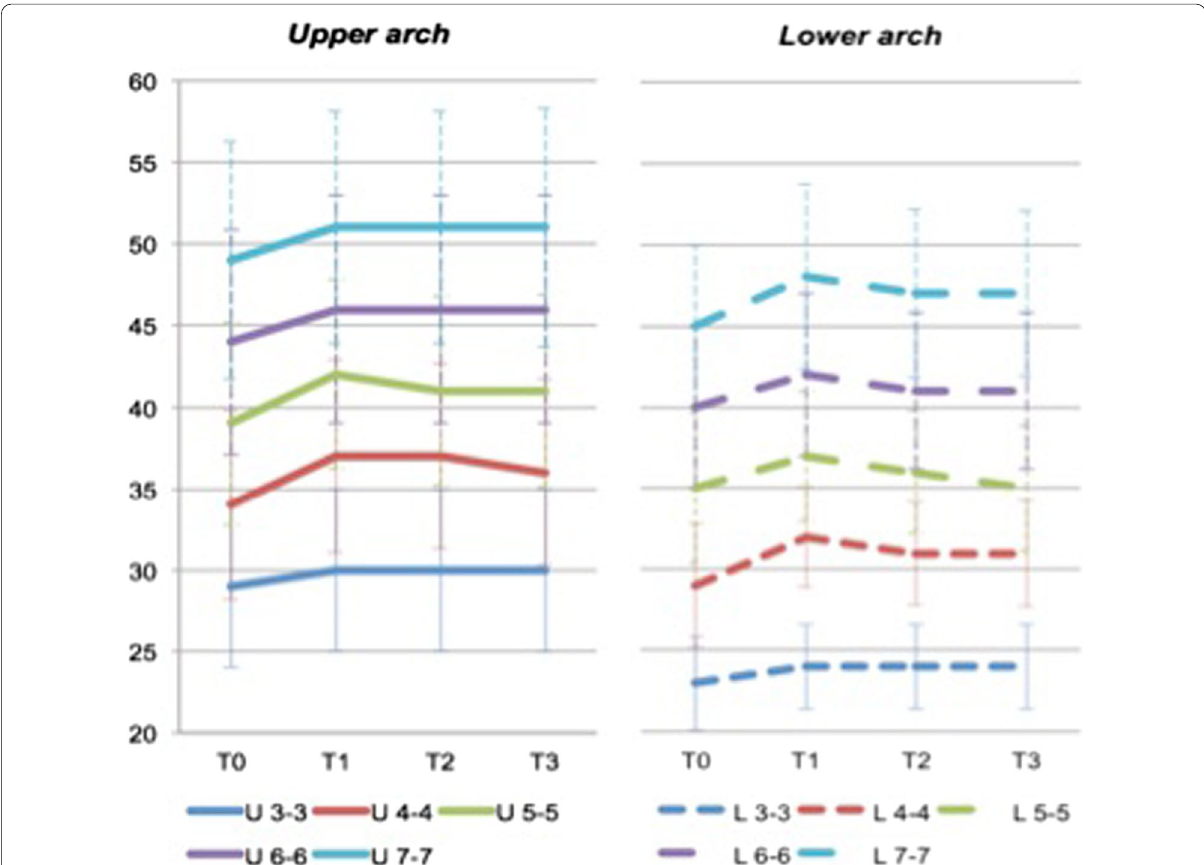
Fig. 2 Graphical representation of the mean diameter ( y axis, in mm) by time ( x axis), in upper ( left ) and lower arch ( right ). T0 T1 after treatment, T2 1 year after treatment, T3 = =